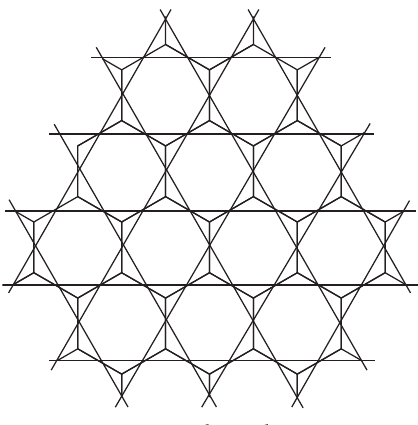
Figure 6: Sheet silicates.